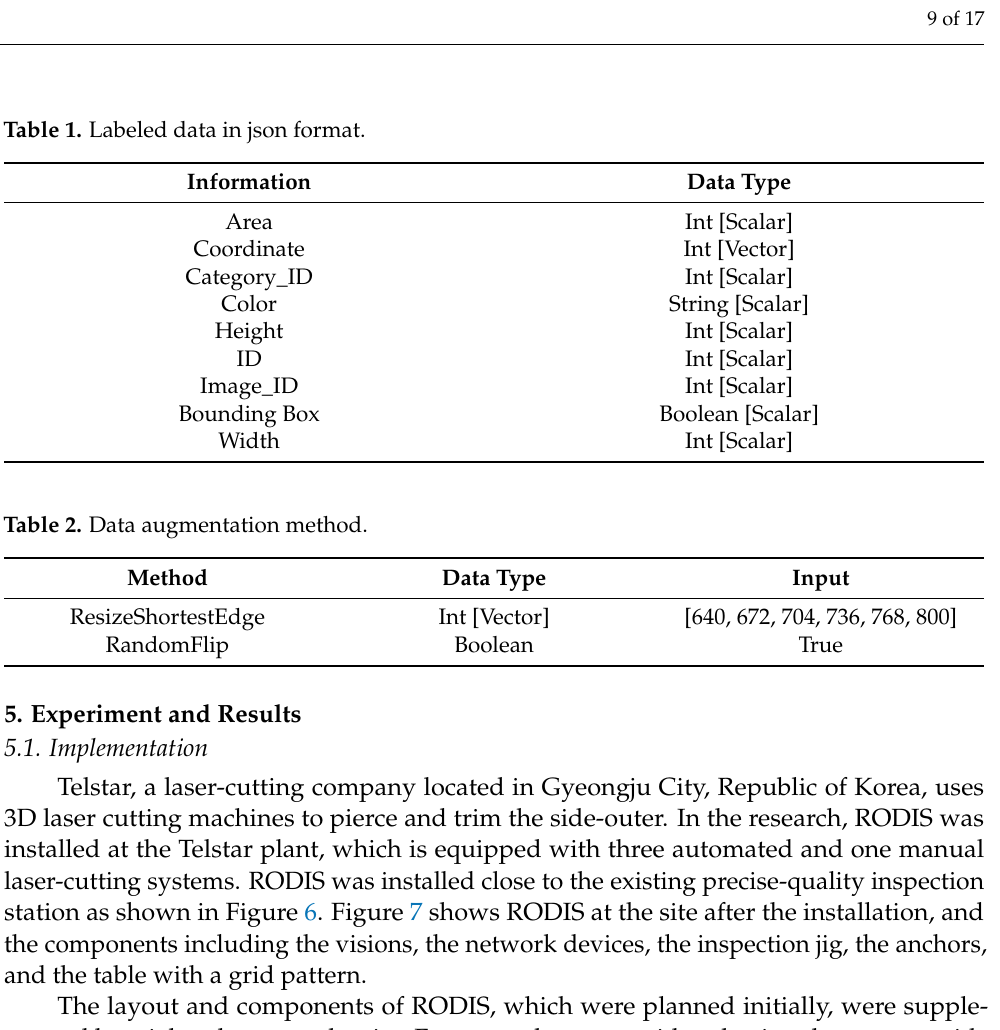
Table 2. Data augmentation method.